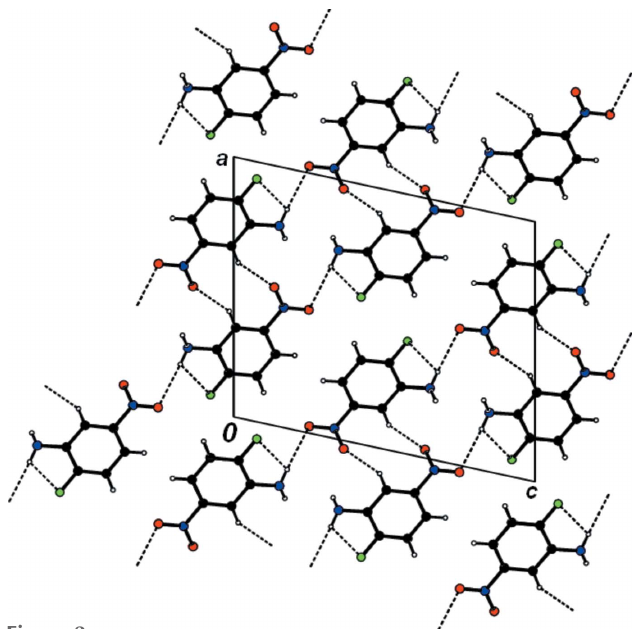
Figure 2 The crystal packing of the title compound, viewed down [010]. The hydrogen bonds are shown as dashed